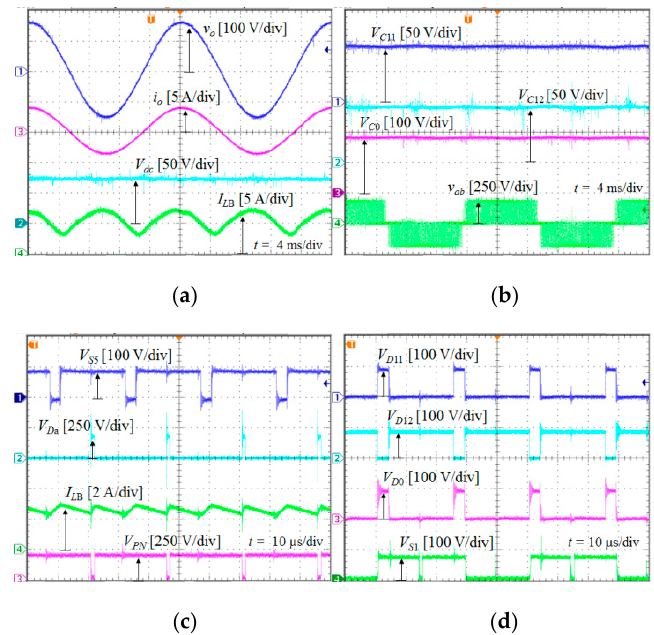
Figure 10. Experimental waveforms for the proposed inverter when V dc = 72 V. From top to bottom: ( a ) output voltage after the L-C filter, load current, input current, and input voltage; ( b ) voltages across capacitors C 11 , C 12 , and C 0 , and output voltage before the L-C filter, ( c ) drain-source S 5 voltage, diode D a voltage, input current, and dc-link voltage; and ( d ) voltages across diodes D 11 , D 12 , and D 0 , and the drain-source S 1 voltage.